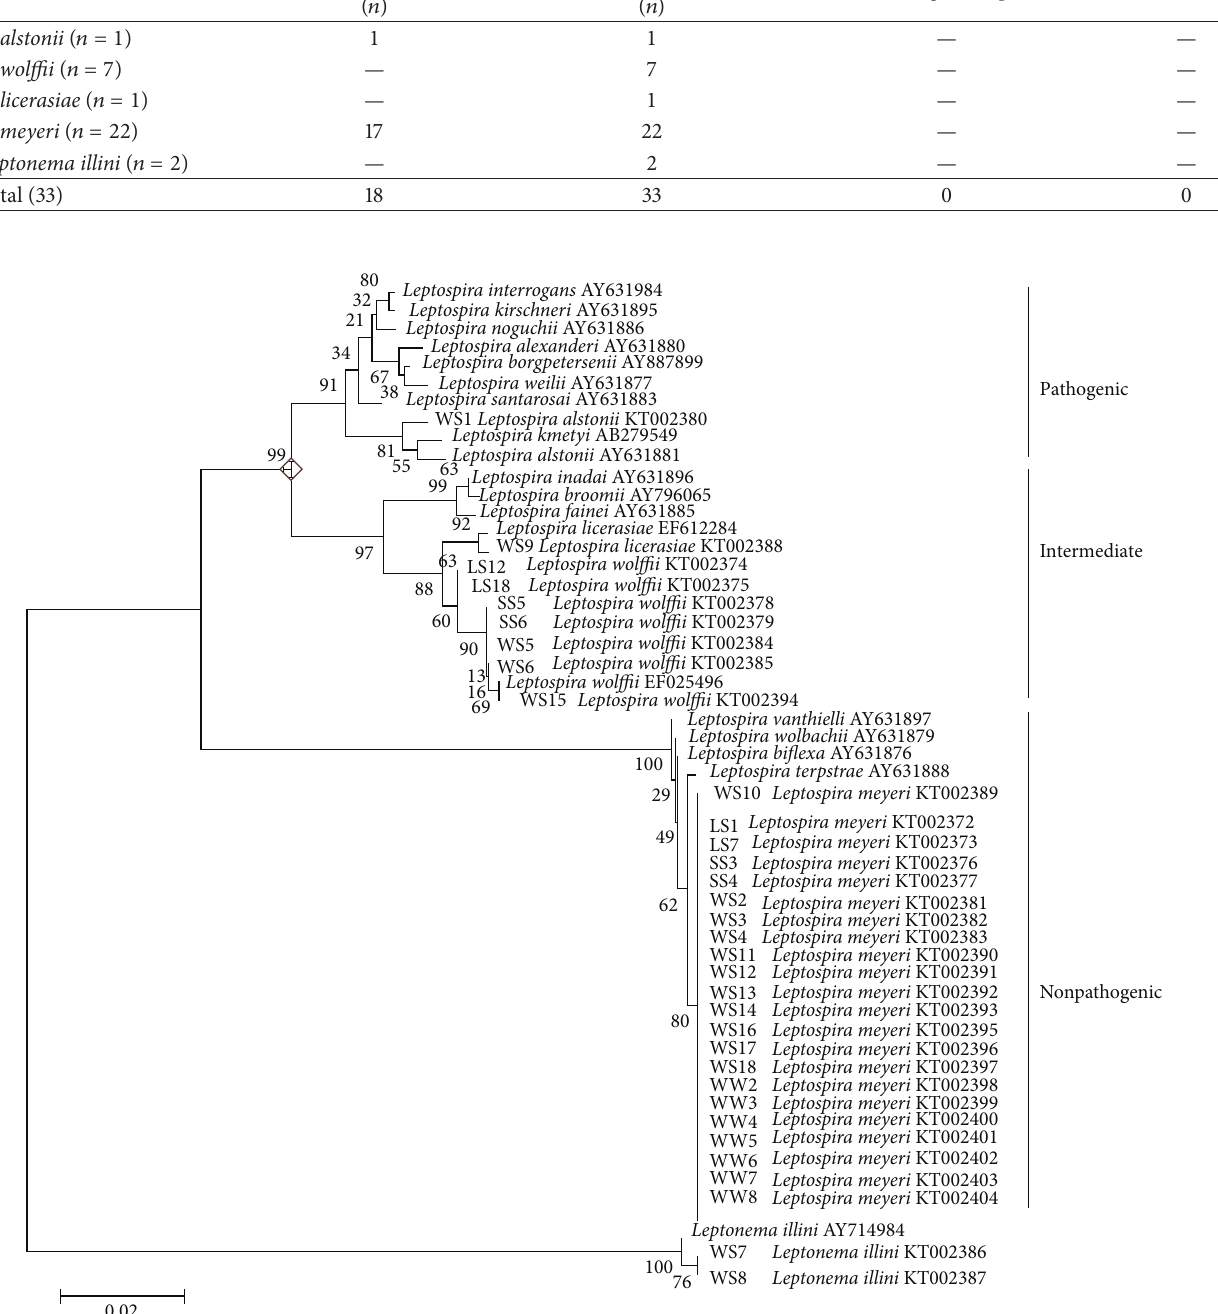
Figure 2: A phylogenetic tree generated by the Neighbour-Joining method using MEGA 6 based on 16S rRNA gene sequence of Leptospira isolates and the selected